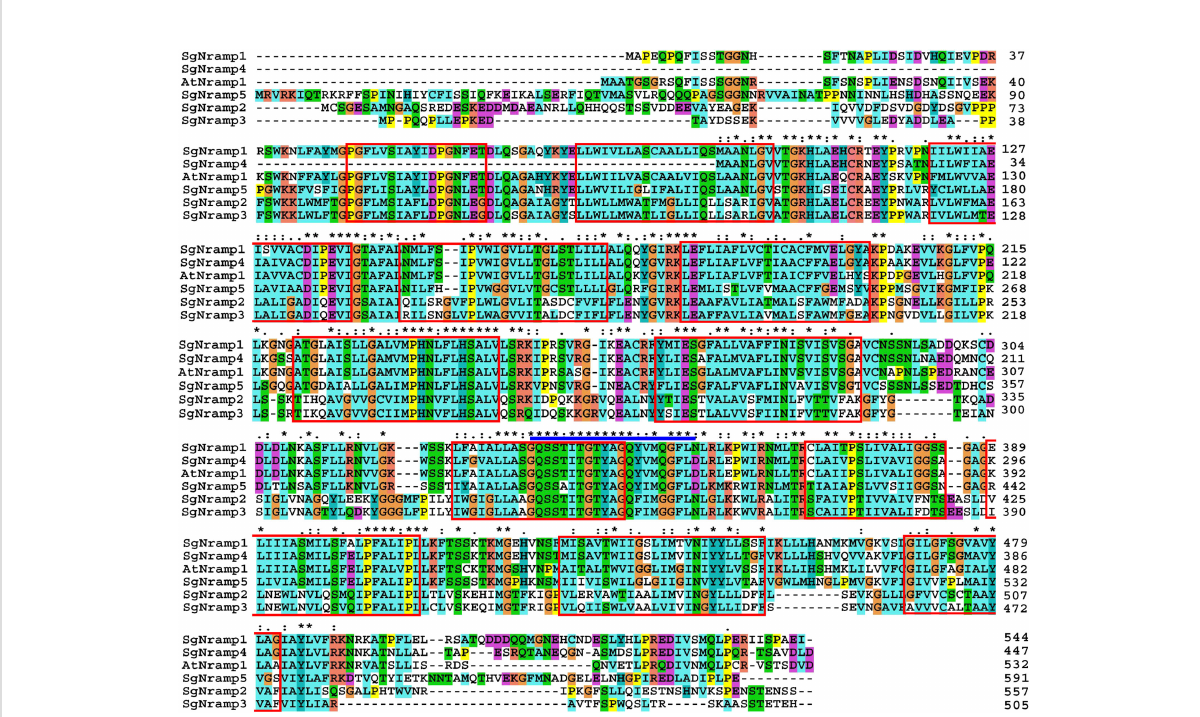
FIGURE 1 Multiple alignment of SgNramps from S. guianensis and AtNramp1 from Arabidopsis. The transmembrane domains (TMDs) were boxed with red color. The unique amino acid residues of the Nramp proteins were labeled with blue line above the sequence. The following Nramp proteins were used: SgNramp1 (ON338040), SgNramp2 (ON338041), SgNramp3 (ON338042), SgNramp4 (ON338043), SgNramp5 (ON338044), and AtNramp1 (At1g80830). * in the fi gure indicates the same amino acid residue included in all Nramp